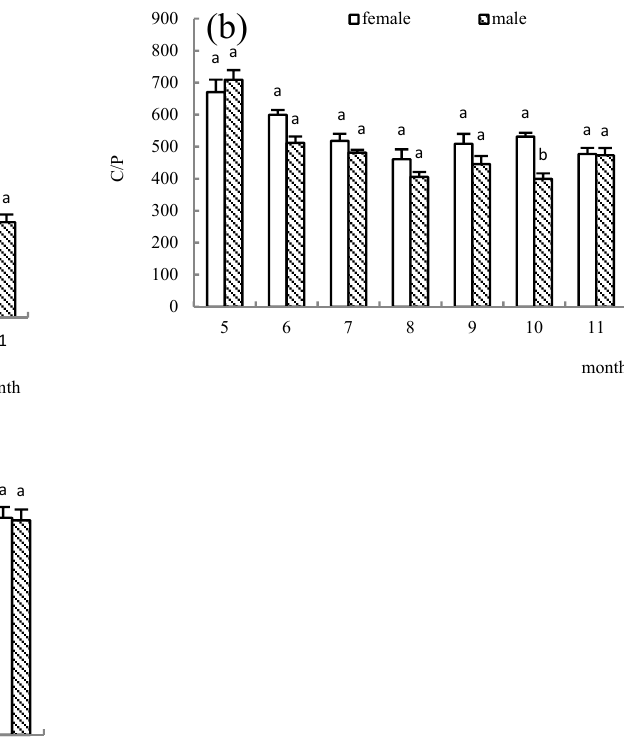
Figure 7. Comparation of C/N ( a ), C/P ( b ), N/P ( c ) ratios in leaf of female and male plants of F. velutina during the growing season. Note: Means not sharing the same letter of female and male plants in the same month indicated significant differences between males and females at an alpha level of 0.05, according to one-way ANOVA.